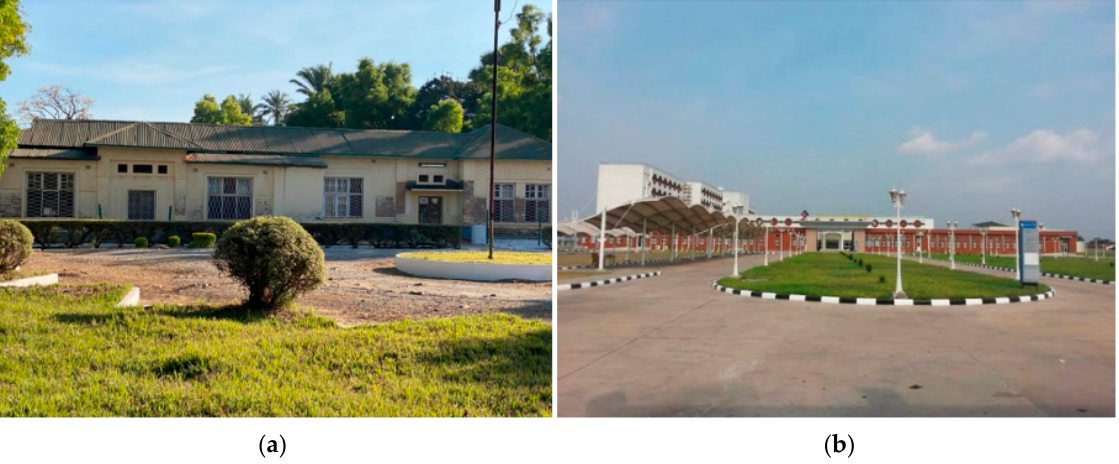
Figure 1. Shows the external view of the hospitals; ( a ) Gecamine Hospital and ( b ) Cinquantenaire